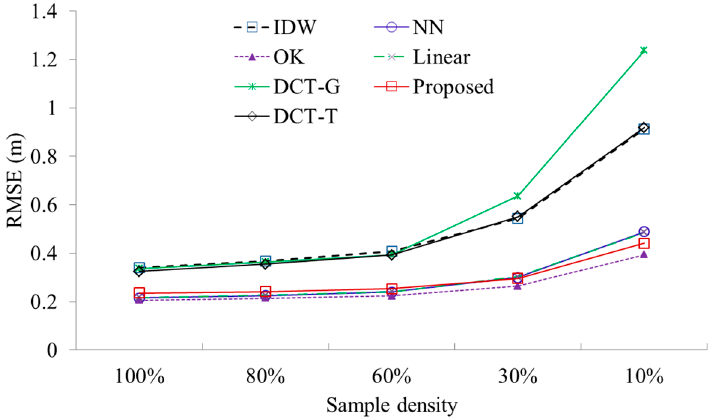
Figure 10. Relationships between sample density and RMSE of the proposed method and the other interpolation methods.